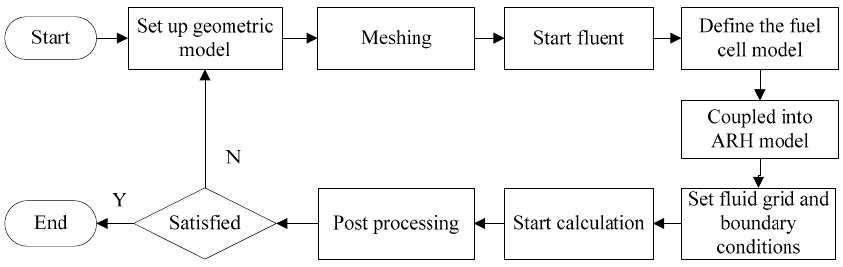
Figure 1. The fuel cell numerical analysis schematic.